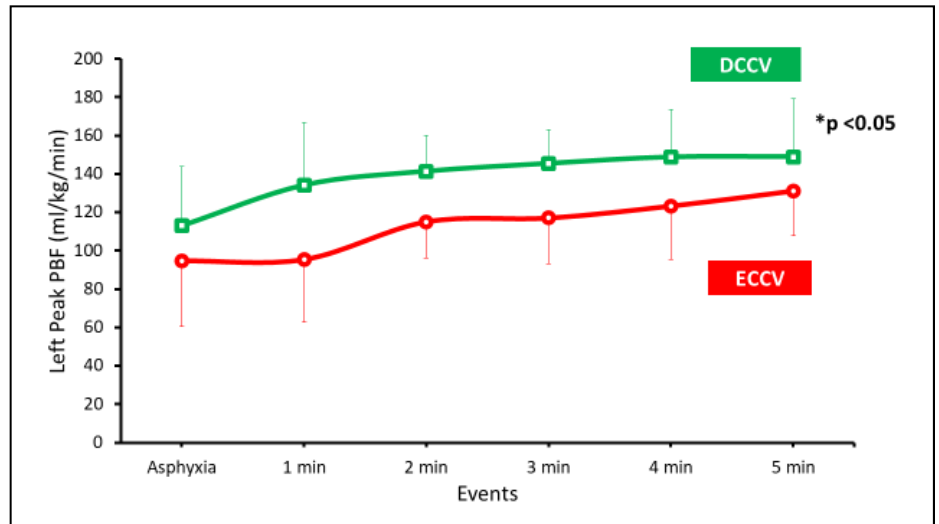
Figure 6. The left peak PBF is shown on the y-axis and the events on the x-axis. The PBF was significantly higher with DCCV compared to ECCV (* p < 0.05 by ANOVA). Carotid blood flow—the peak left carotid blood flow (CBF) was not different between the two groups as shown in Figure 7.